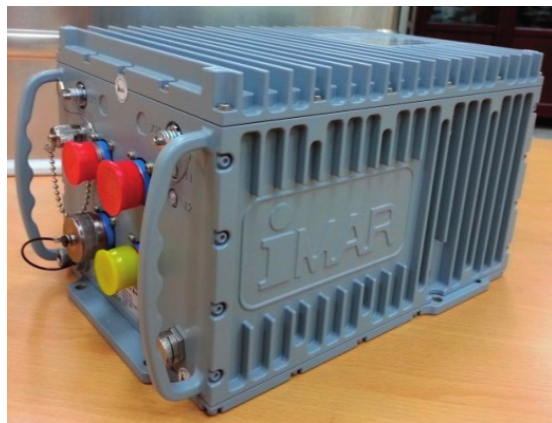
Figure 2. ( a ) Setup of sensors applied for the land-based system. ( b ) A steel box used for protecting IMU and the GNSS antenna was installed on top of its. ( c ) A zoom-in view of (b).